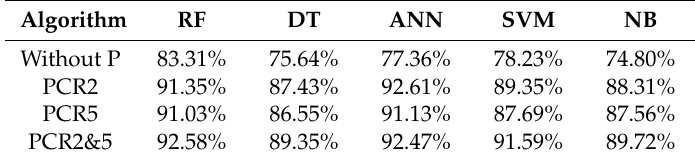
Table 7. Multi-floor motion recognition accuracy comparison using different algorithm.